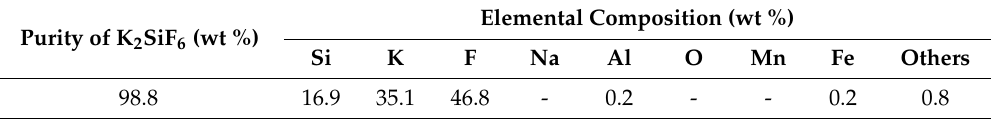
Table 2. Purity of K 2 SiF 6 .